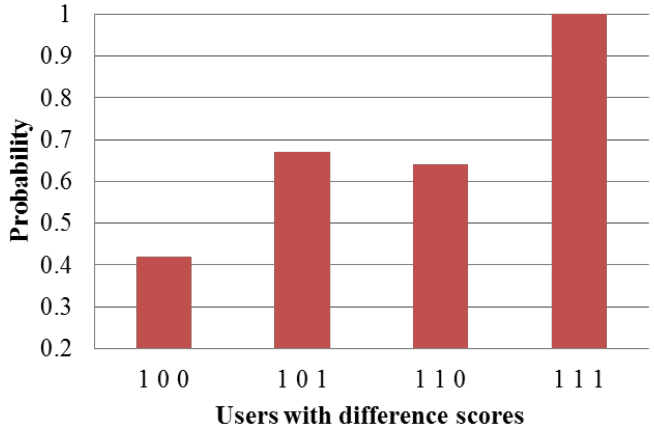
Figure 10. Finding results when α = 0.8, β = 0.1, and γ = 0.1.